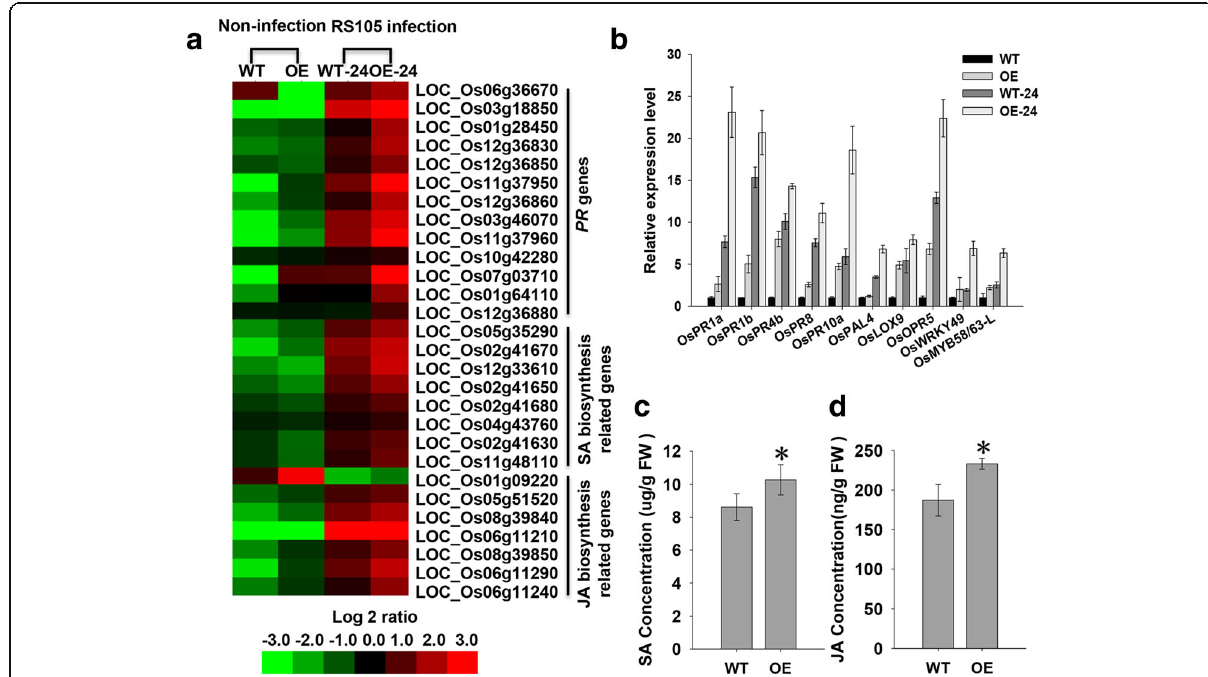
Fig. 6 Expression of pathogenesis-related genes and SA and JA biosynthesis-related genes in wild-type and transgenic lines. a Hierarchical clustering analysis of PR genes and SA and JA biosynthesis-related genes using RNA-seq data. b Quantitative RT-PCR analysis of 10 selected PR genes to validate the RNA-seq data of up-regulated genes. c The content of SA. d The content of JA. The data are shown as the means ± SD of three biological replicates. The experiments were repeated two